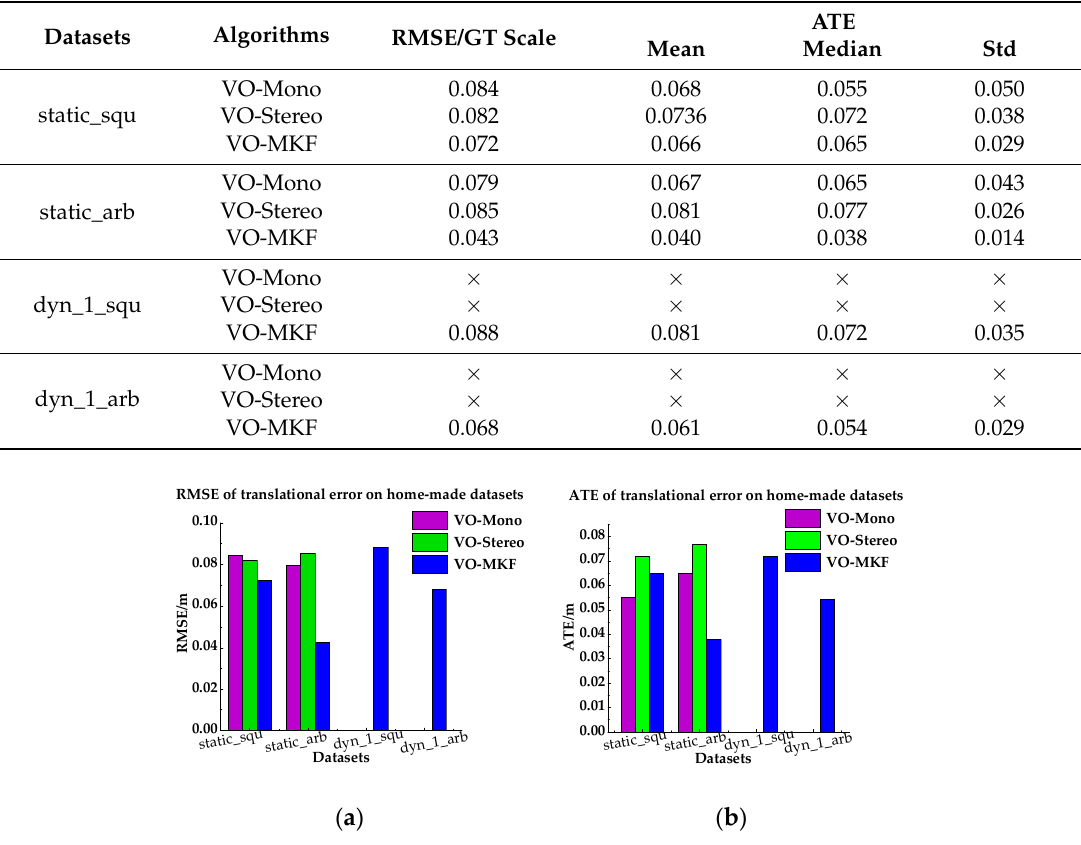
Table 2. The root mean square error (RMSE/m) and absolute trajectory error (ATE/m) results of VO-Mono, VO-Stereo and VO-MKF on home-made datasets.